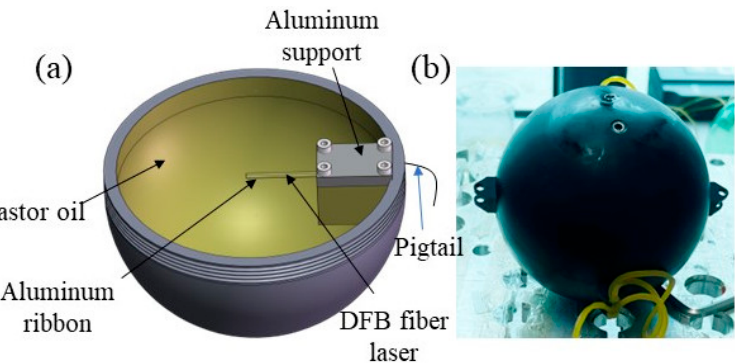
Figure 9. ( a ) The schematic of the velocity sensor. ( b ) Photograph of the assembled velocity sensor.